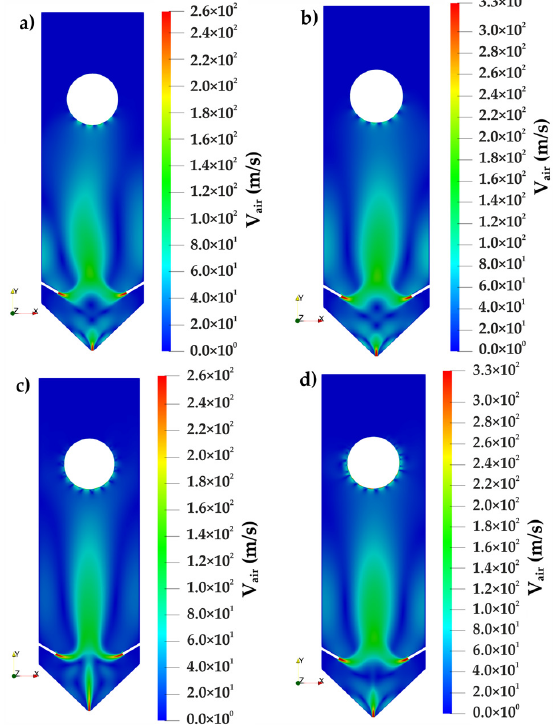
Figure 9. Time-averaged air velocity distribution (resultant velocity) as a function of the solid holdup and the nozzle inlet pressure: ( a ) 400 g and 0.5 bar; ( b ) 400 g and 1 bar; ( c ) 700 g and 0.5 bar; ( d ) 700 g and 1 bar.